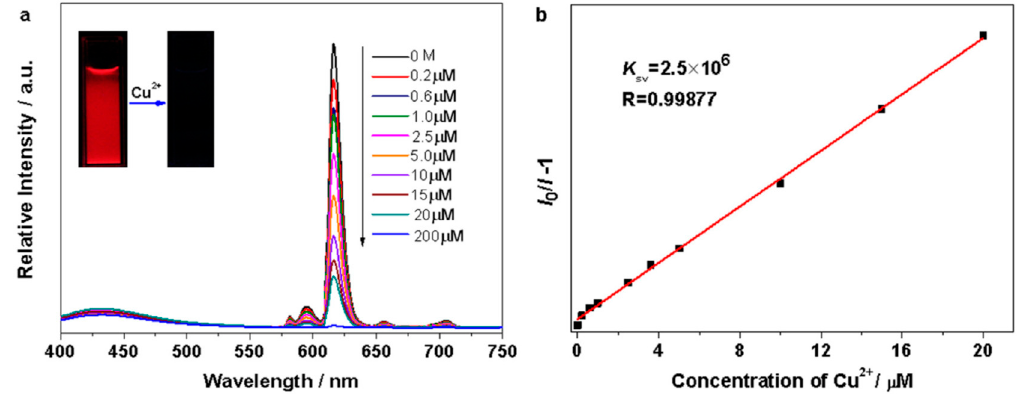
Figure 11. ( a ) The photoluminescence spectra of the PMO prepared through the co-condensation of 1,2-bis(triethoxysilyl)ethane and modified 4 ′ -(4-carboxy-methyleneoxy phenyl)-2,2 ′ :6 ′ ,2”-terpyridine in Cu(NO 3 ) 2 aqueous solution at different concentrations (excited at 333 nm). The inset shows changes in luminescence following the addition of Cu 2+ ions (2 x 10 − 4 M) to the Eu 3+ grafted PMO suspension under UV light (365 nm). ( b ) Stern–Volmer plot for the PMO hybrid material sensing of Cu 2+ ions at the range of 0-2 x 10 − 5 M in aqueous solution [60].